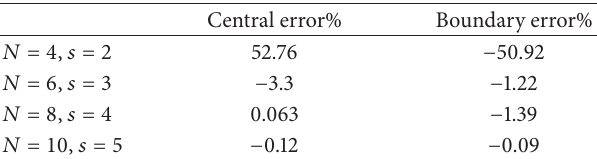
Table 2: Central ( 𝑥 = 0.5 ; 𝑦 = 0.5 ) and boundary ( 𝑥 = 0 ; 𝑦 = 0 ) error relative to maximum bending deflection of an C-C-C-Csquare plate of unit size.